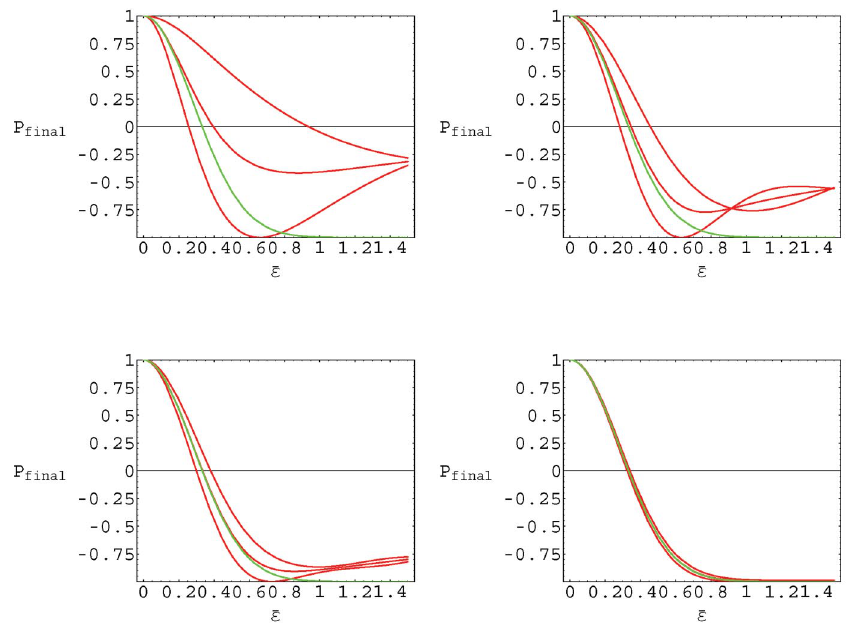
FIG. 6. (Color) Final polarization after crossing a resonance in a sloped-step pattern as function of (cid:5) (cid:3) for four different values of (cid:5) A . Red curves give the mean, upper bound, and lower bound of the oscillating final polarization. Green curves are given by the Froissart-Stora